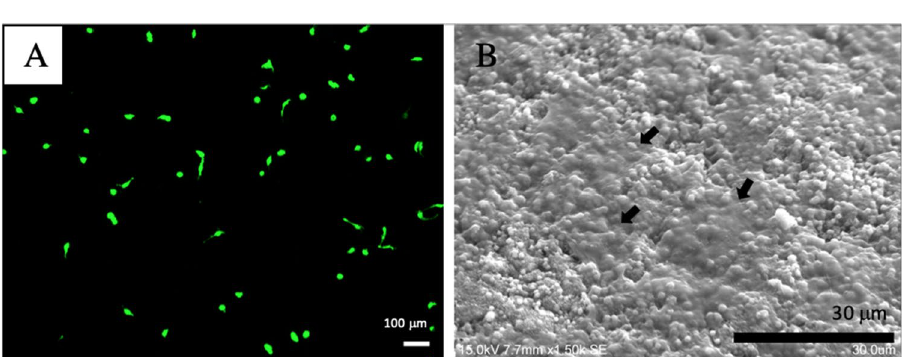
Figure 7. MC3T3-E1 cultured on synthesized biomaterial after 3 days on ( A ) LCSM; ( B ) SEM, with the arrows represent attached MC3T3-E1